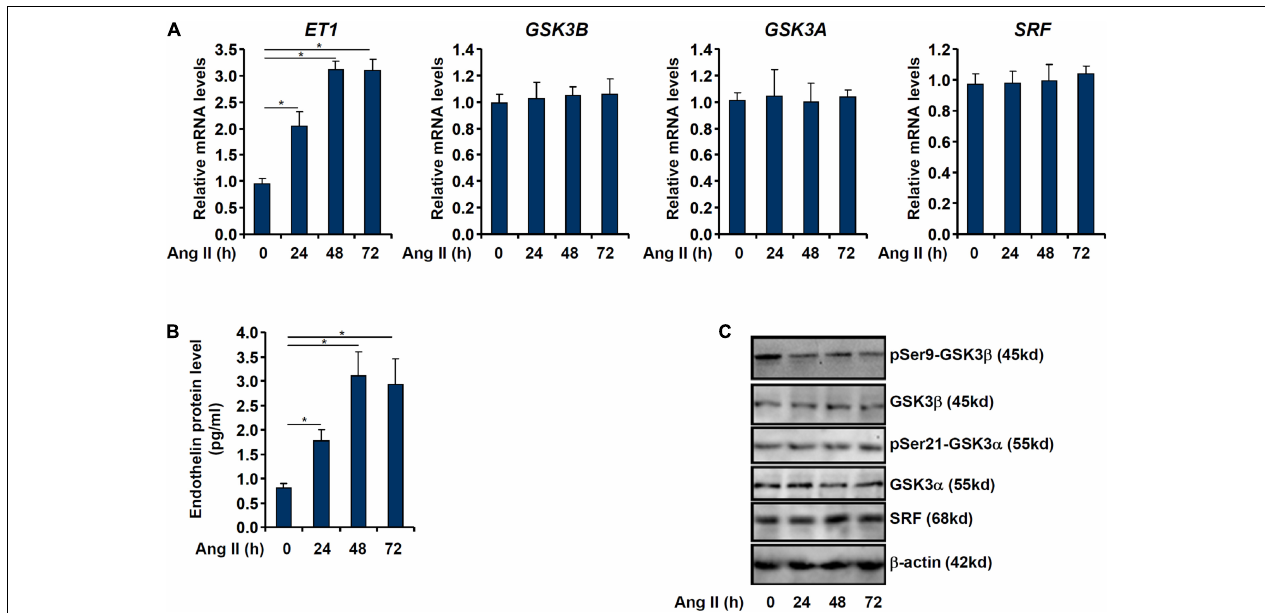
FIGURE 1 | Ang II induced endothelin expression parallels GSK3 activation. EAhy926 cells were treated with Ang II (0.1 µ M) and harvested at indicated time points. Endothelin expression levels were examined by qPCR (A) and ELISA (B) . GSK3 phosphorylation was examined by Western (C) . Error bars represent SD (* p < 0.05, two-way Student’s t -test). All experiments were repeated three times and one representative experiment is